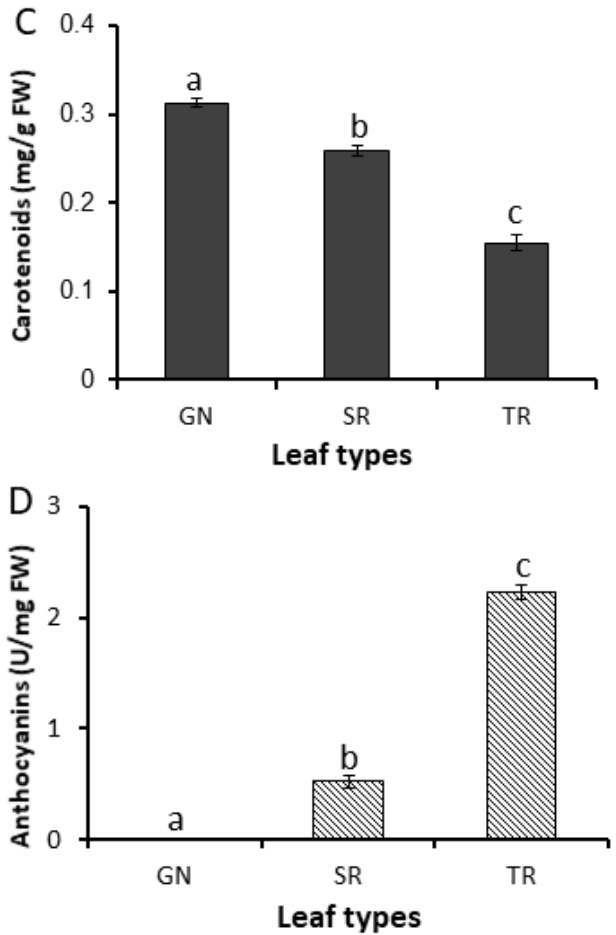
Figure 1. Phenotype and pigment concentrations of three types of leaves (GN, green; SR, semi-red; TR, total-red). ( A ) Phenotype of representative leaves with differential color on the same branch when samples were collected. ( B ) concentration of total chlorophyll, ( C ) carotenoids and ( D ) anthocyanins in leaves. One unit of anthocyanin concentration was expressed as a change of 0.1 absorption of methanolic extracts (U/mg FW) (see Section 4). Values are means ± SD ( n = 3). The statistical significance among means ± SD ( n = 3) among three types of leaves was indicated by different lower letters at p < 0.05.